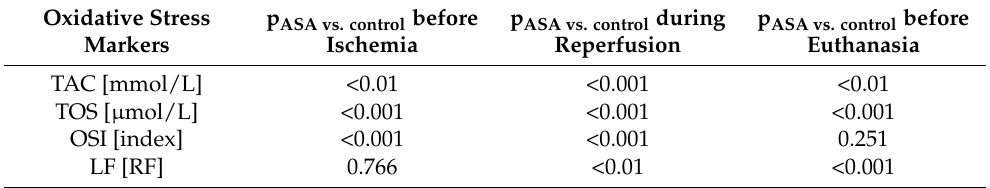
Table 5. Contrast analysis for repeated measures of oxidative stress marker levels in the serum of pigs subjected to a myocardial ischemia-reperfusion protocol assessing the effectiveness of intracoronary administered acetylsalicylic acid